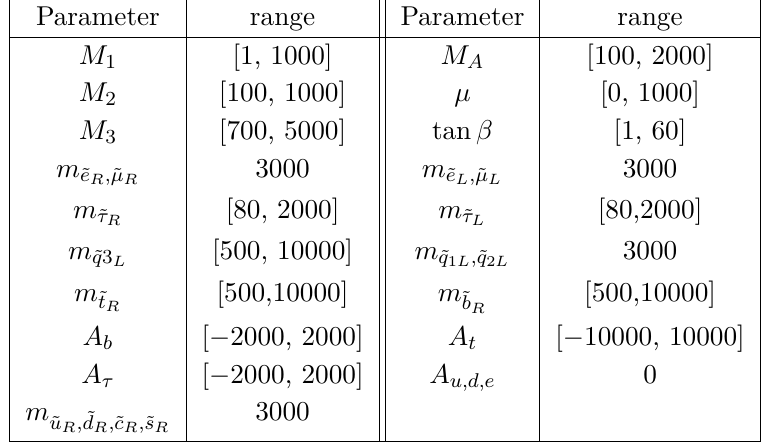
Table 1. The ranges of MSSM parameters searched by random scan. The mass scales are in GeV units.